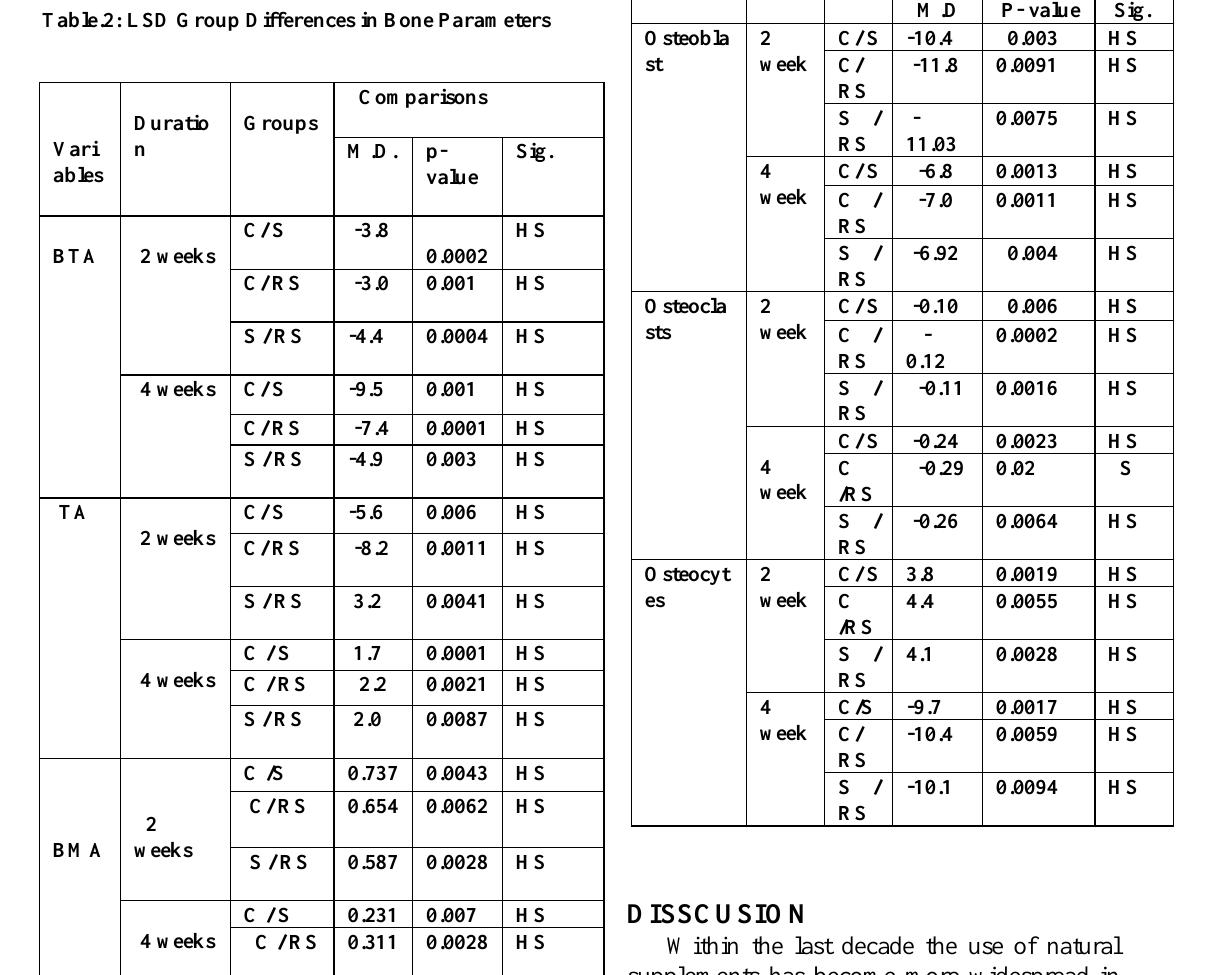
Table.2: LSD Group Differences in Bone